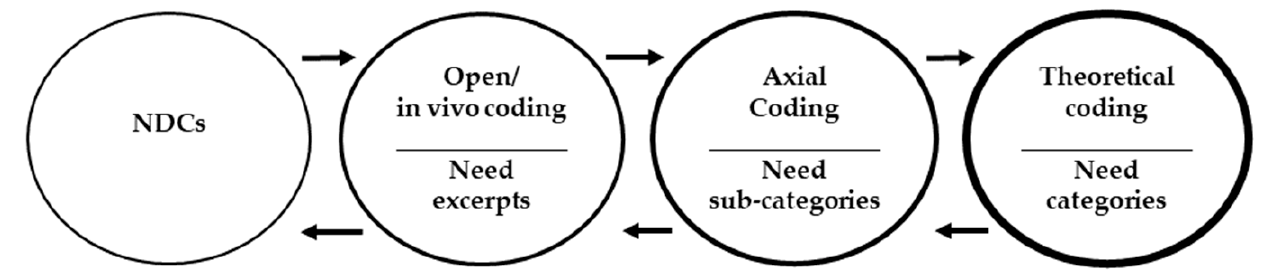
Figure 1. Iterative process of identifying needs and coding them into categories.